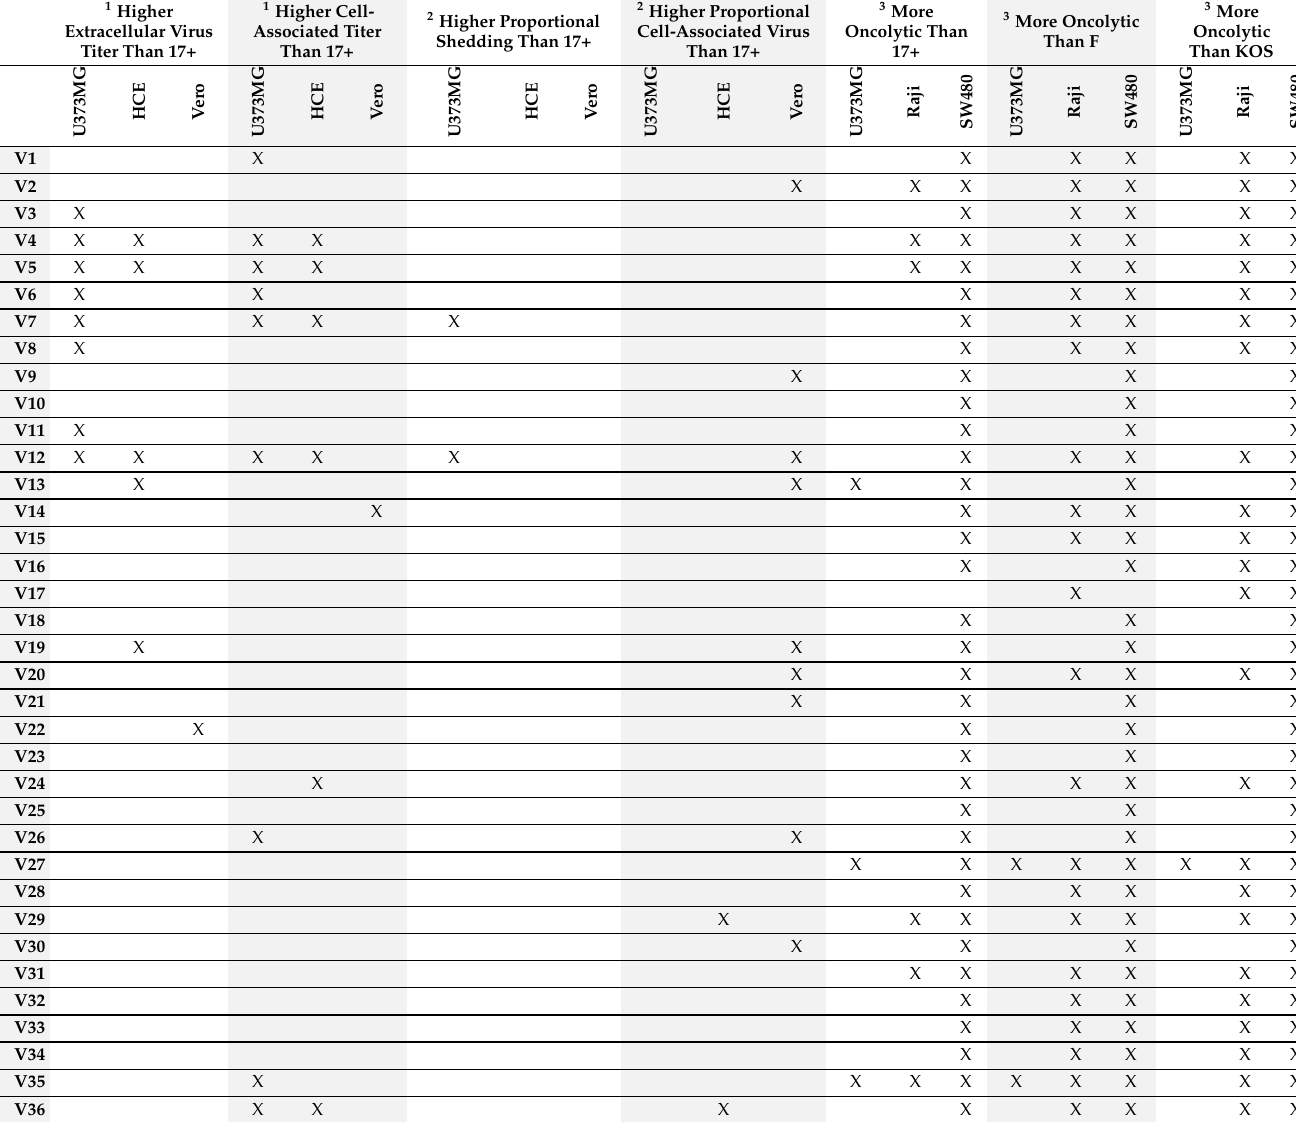
1 Data in Figure 2, 2 Data in Table 3, 3 Data in Figure